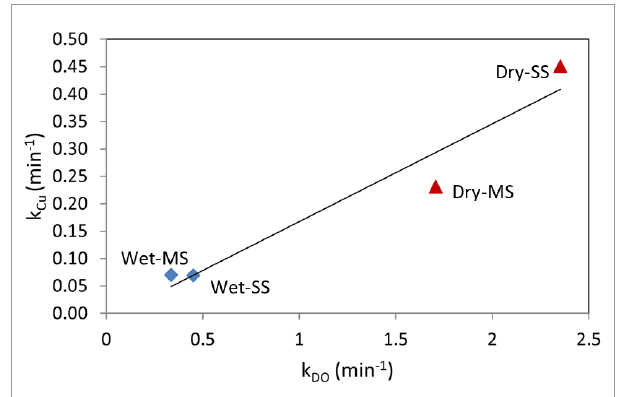
Figure 3. DO concentrations in the pulp during flotation for different milling conditions.